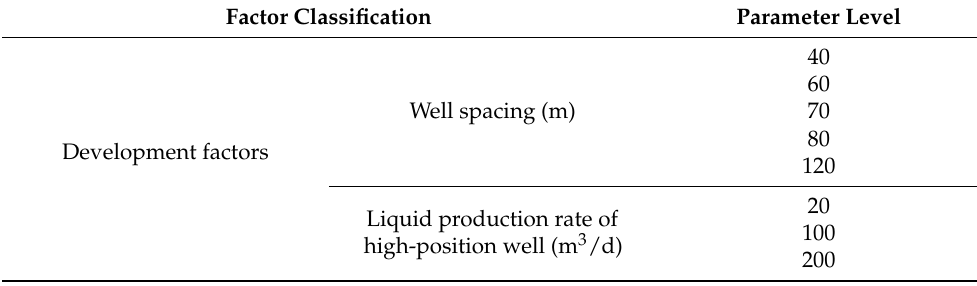
Table 6. Factors and parameter levels of the single-well synergistic mode.